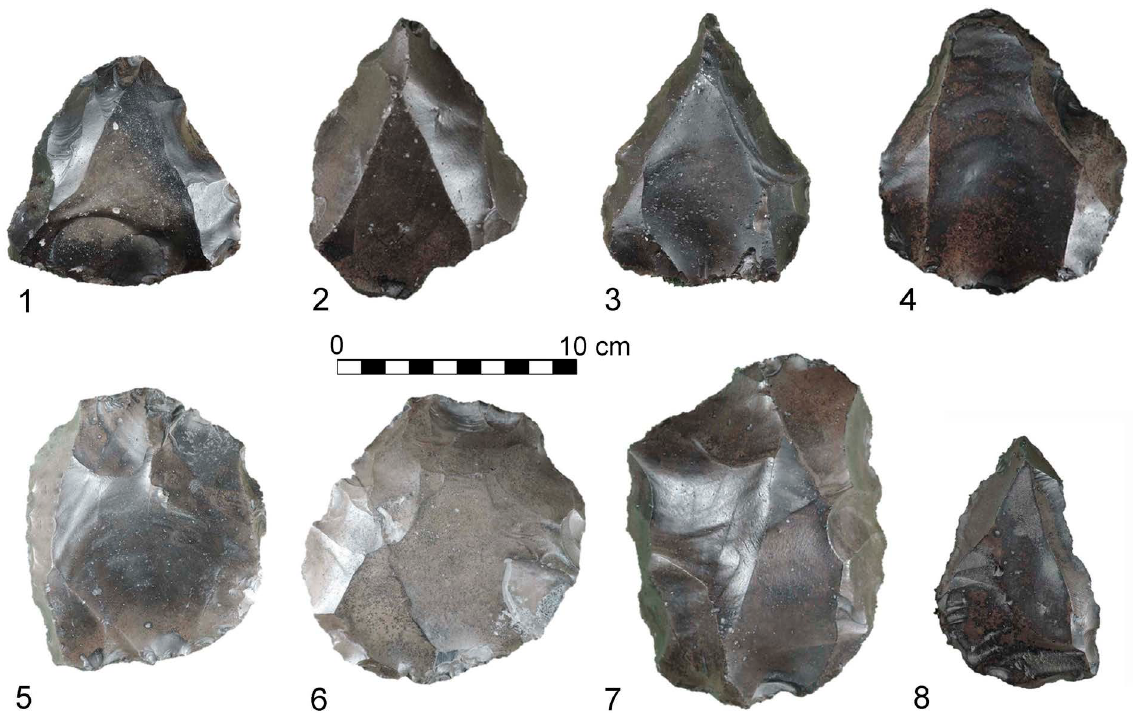
Figure 7. Selected artifacts from Nahal Paran 9: 1, Nubian Type II core (1-344_2), 2-3 Nubian Type I cores (2- 345_1; 3-344_1), 4-6 Levallois centripetal preferential cores (4-346_7; 5-346_4; 6-346_5), 7 Levallois bidirectional preferential for a point (346_1). 8, Levallois or Nubian point (346_8). Length was measured along the axis of the last dominant scar on the flaking